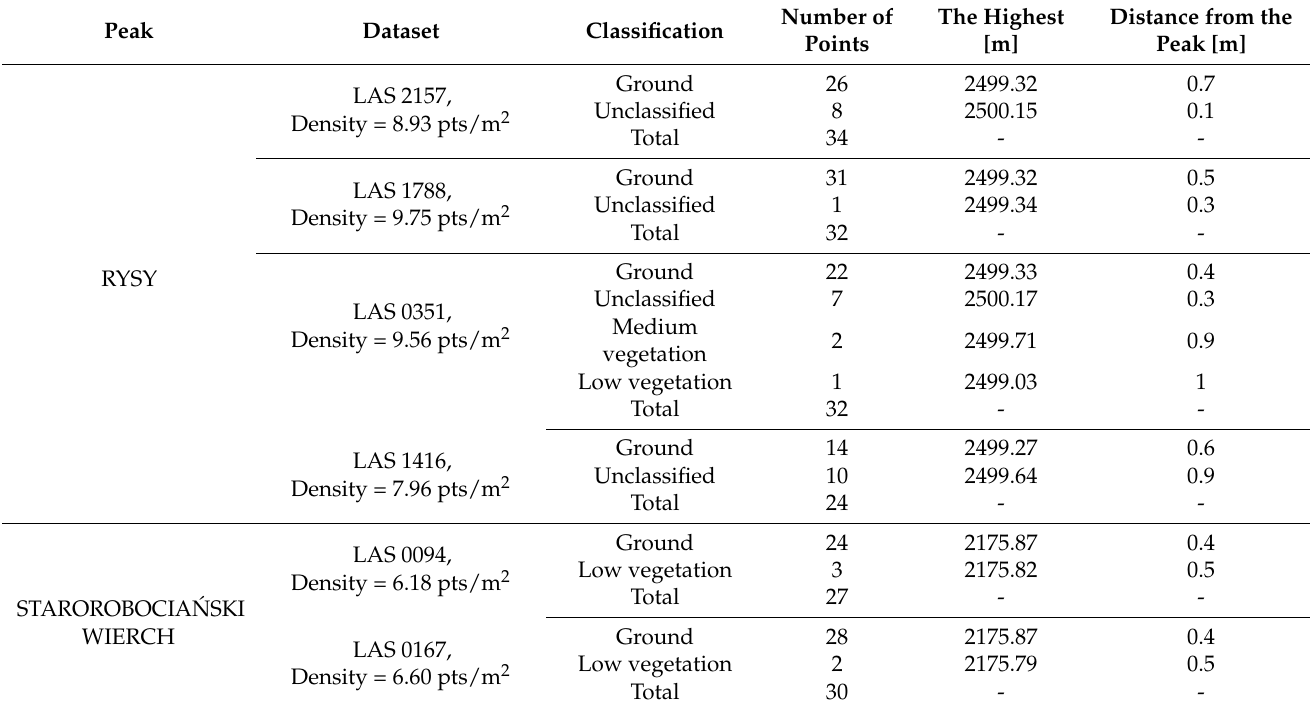
Table 3. Slovak point clouds density, the analysis of points within a radius of 1 m from the OSM peak. Peak